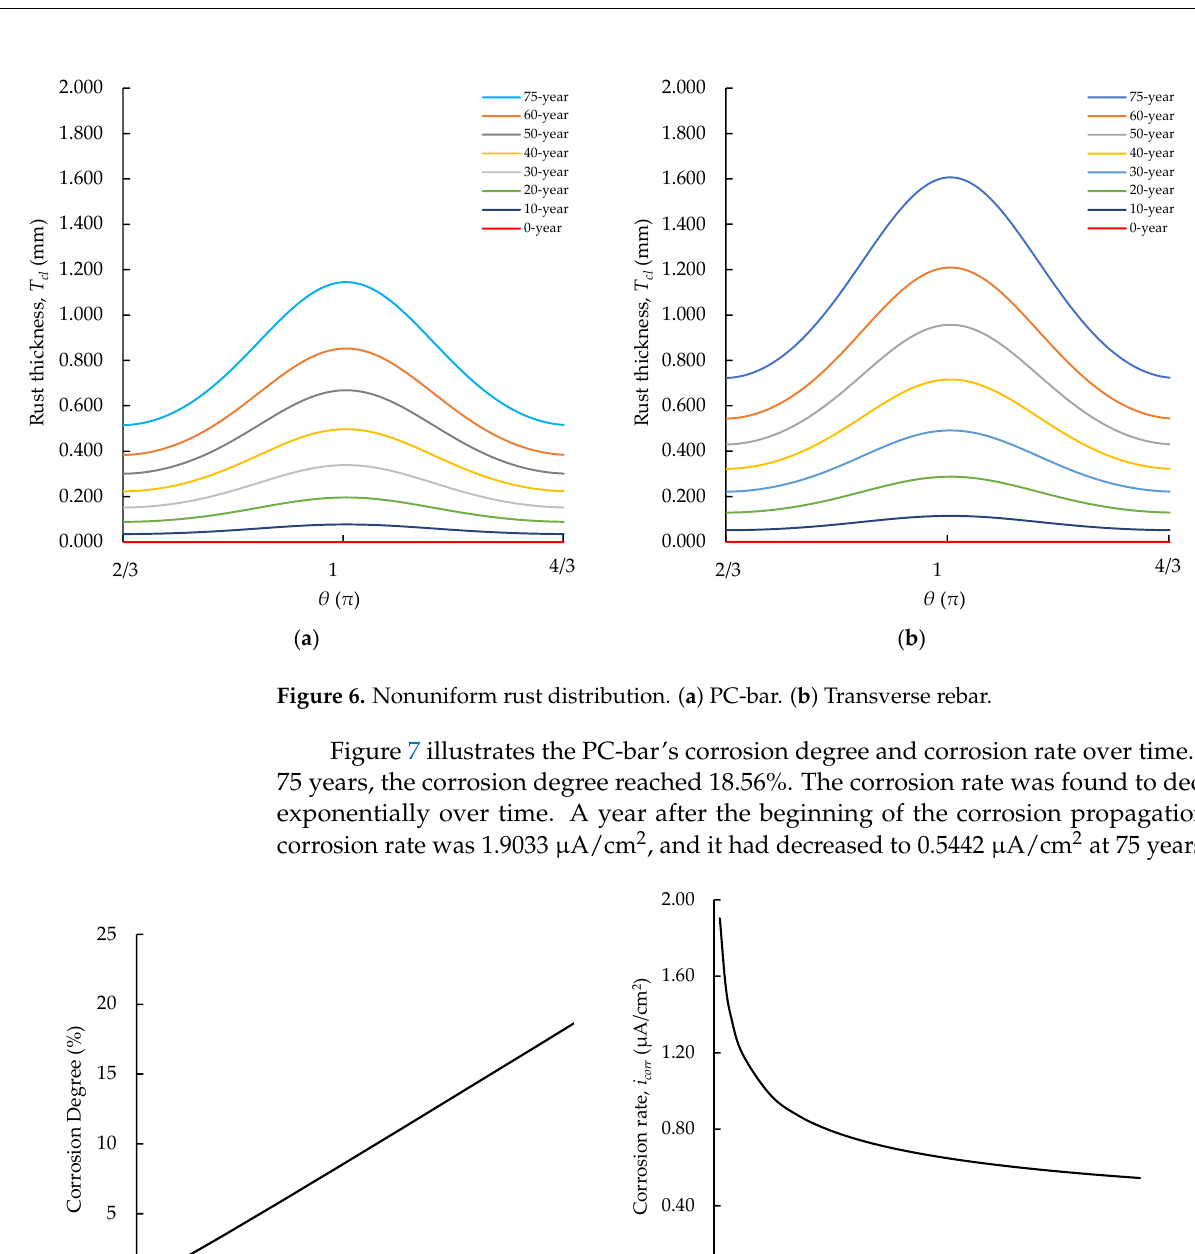
smaller diameter (4 mm), produced a larger rust thickness than PC-bar, which was 9 mm in diameter, for the same corrosion rate.